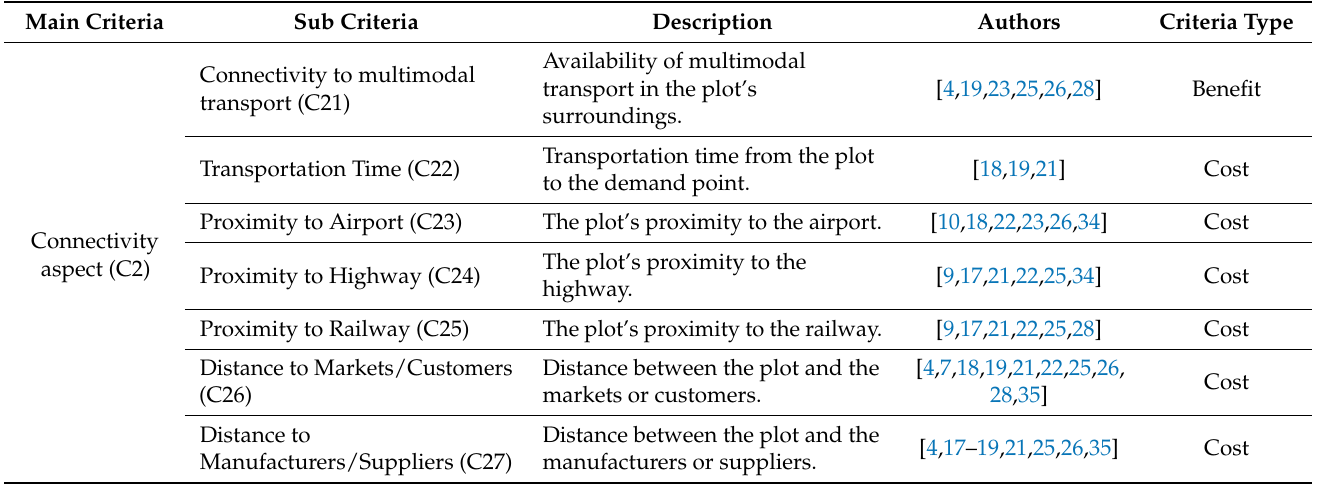
Table 2. Connectivity aspect: Criteria for selection of distribution center location.